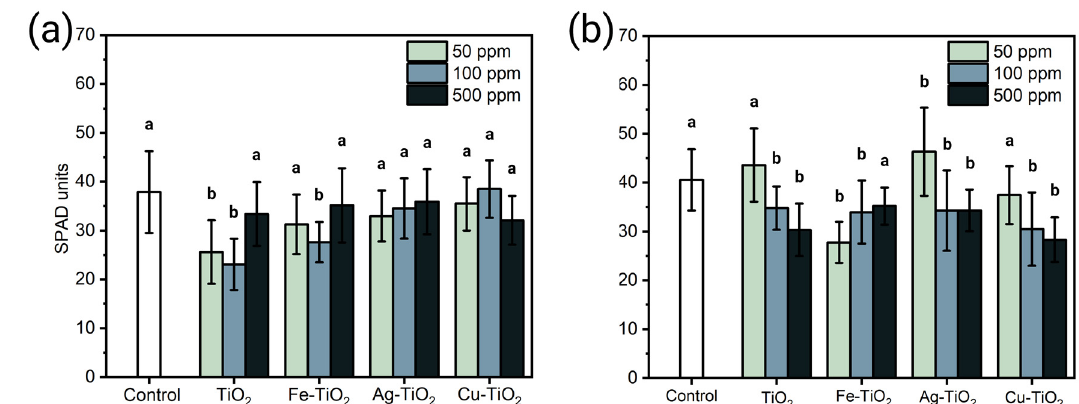
Figure 7. Chlorophyll index measure in SPAD units for alfalfa treated with ( a ) SG- and ( b ) Mw-SG- synthesized NMs. Comparison between means was analyzed using a Dunnett assay with a p ≤ 0.05; means sharing a letter are considered not statistically different.